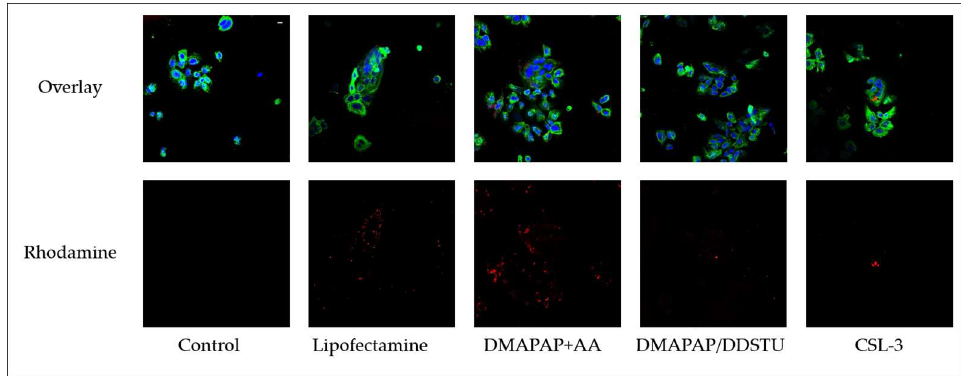
Figure 1. Confocal images comparing siRNA internalization into villous cytotrophoblasts (40×) depending on the formulation (scale bar 10 µm). Nuclei were labelled with DAPI (blue), cytokeratin 7, i.e., cytoskeleton, with Alexa 488 (green), and siRNA with rhodamine (red).